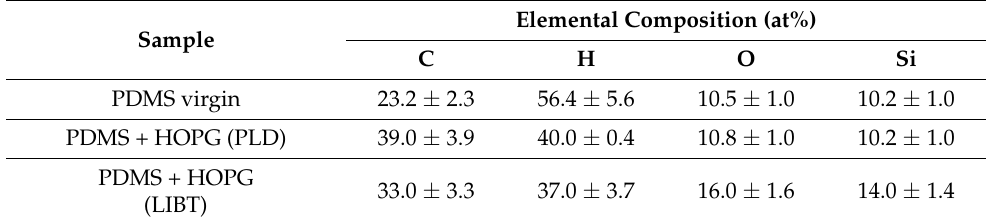
Table 1. Atomic percentage concentration of PDMS and PDMS + HOPG samples deposited by PLD and LIBT and deduced by RBS for the evaluation of C, O, Si and ERDA for the evaluation of H. Elemental Composition (at%) Sample C